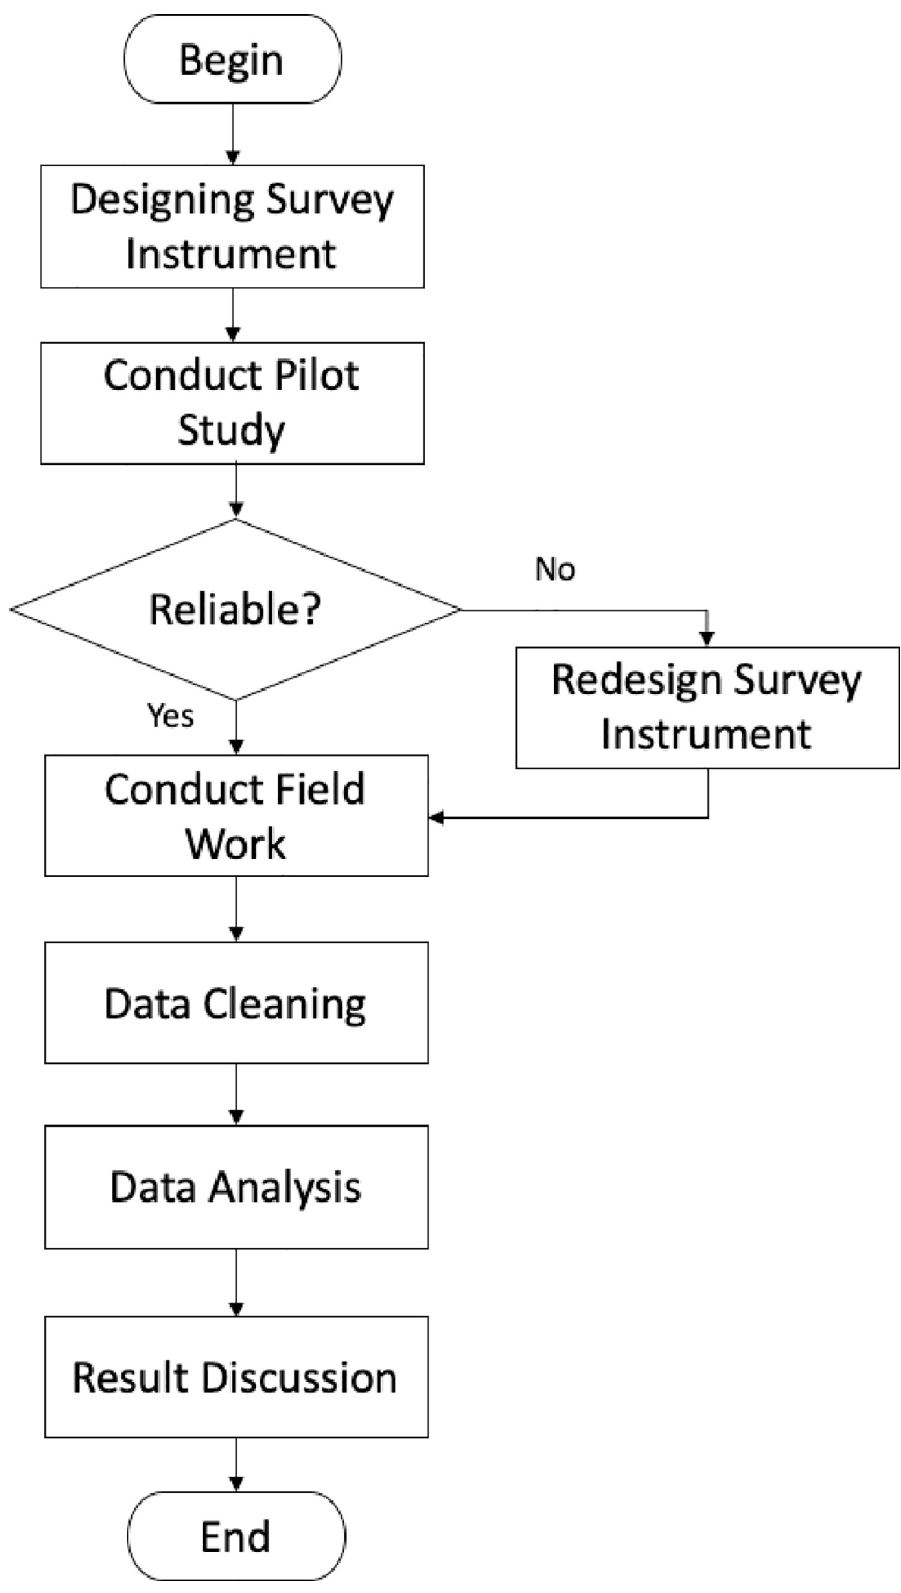
Fig 2. The framework of the study